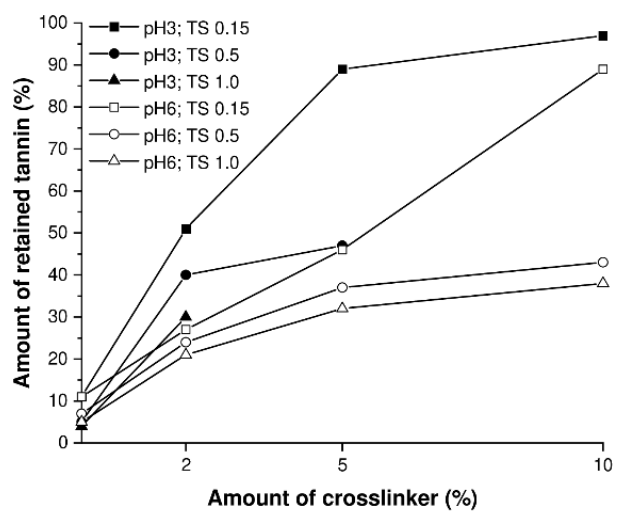
Figure 6. Graphic illustration of the amount of tannin retained in the tannin-silica network, which were generated at a pH value of 3 (full symbols) and 6 (empty symbol) as well as at different T/S ratios of 0.15 (square), 0.5 (hexagon) and 1.0 (triangle). Please note that the lines connecting the measured data points do not rely on a theoretical function but rather are used for clarity reasons.